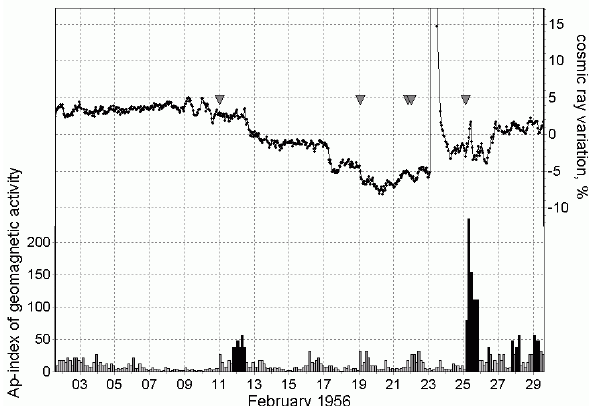
Fig. 1. Counting rate variations for the largest GLEs in different solar cycles.